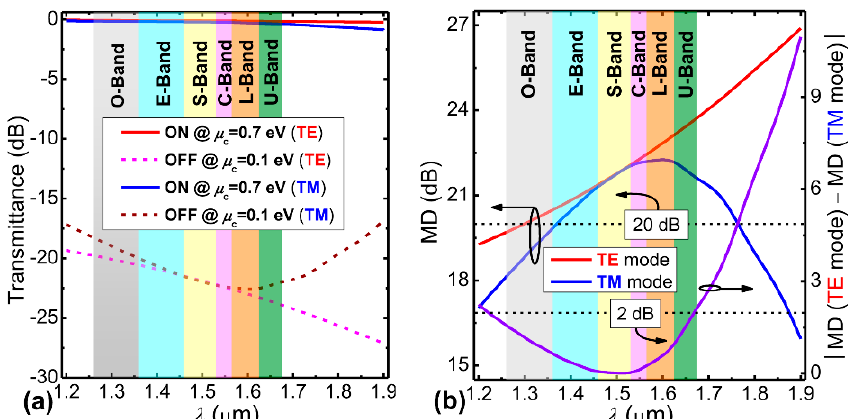
Figure 6. Transmission spectra and the derived wavelength-dependence of the modulation depths. ( a ) Transmission spectra of the proposed EAM at the “ON” and “OFF” states for both polarizations. The length of the EAM is 20 µm. ( b ) The corresponding modulation depths (MDs) and their absolute difference for both polarizations versus the same wavelength range. The two horizontal lines represent the MD of 20 dB and MD discrepancy of 2 dB, respectively.